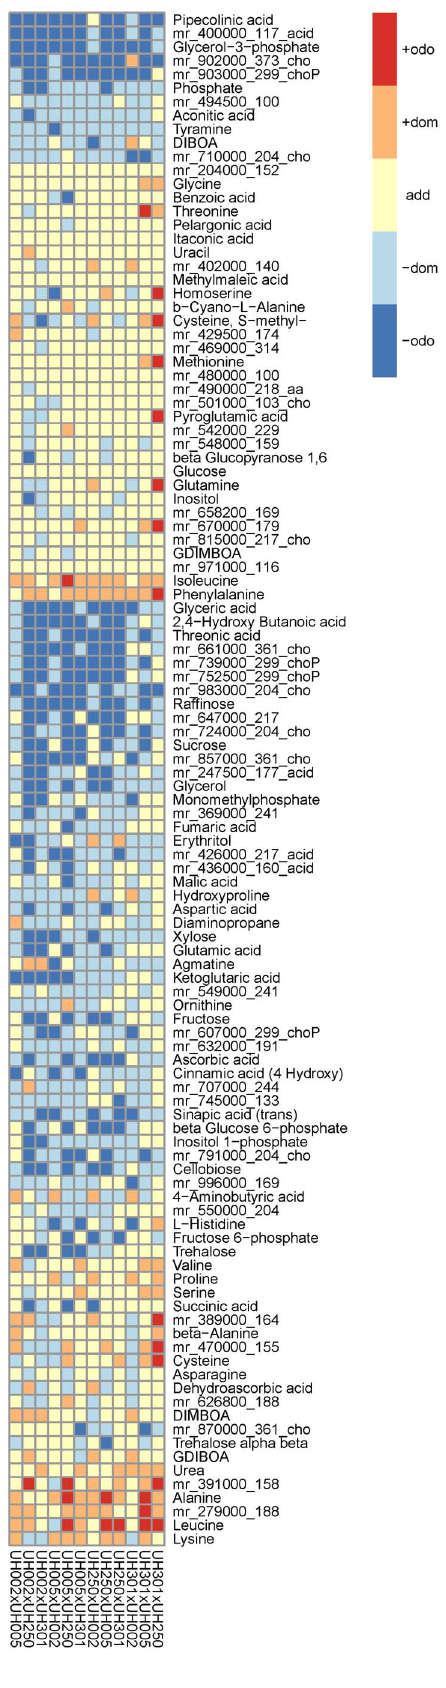
Figure 1. Hybrid class label matrix. The hybrid class label matrix is established using moderated t-statistics (cf. Methods). It shows the observed metabolite heterosis mode of action in all hybrids. Metabolites with unbalanced class labels (e.g. predominantly showing similar class, upper 53 rows) were excluded before conducting classification methods. Various classification methods were used on parental metabolite data to investigate which parental metabolites allow to predict the observed classes within